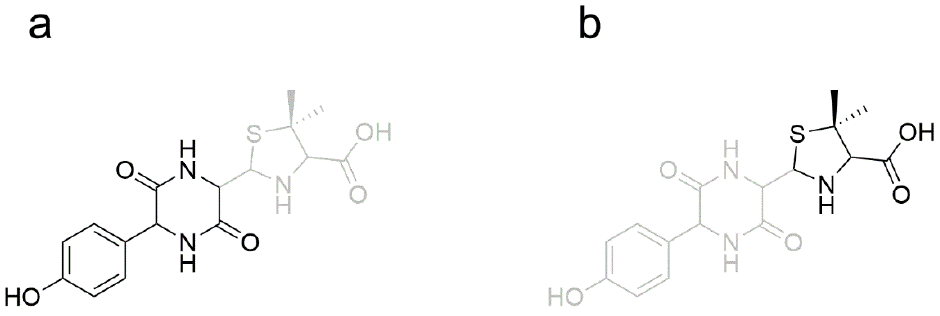
Figure 16. Possible structure of fragment ions in amoxicillin diketopiperazine. ( a ) Possible structure of fragment m / z 207 ion; ( b ) Possible structure of fragment m / z 160 ion.